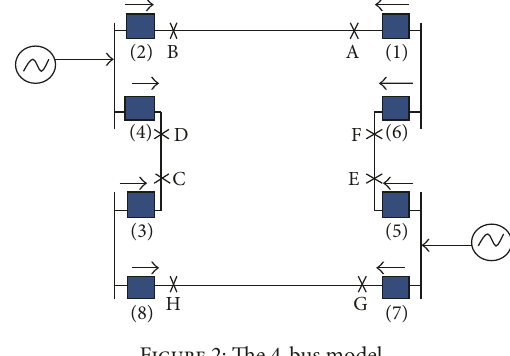
Figure 1: The 3-bus model.